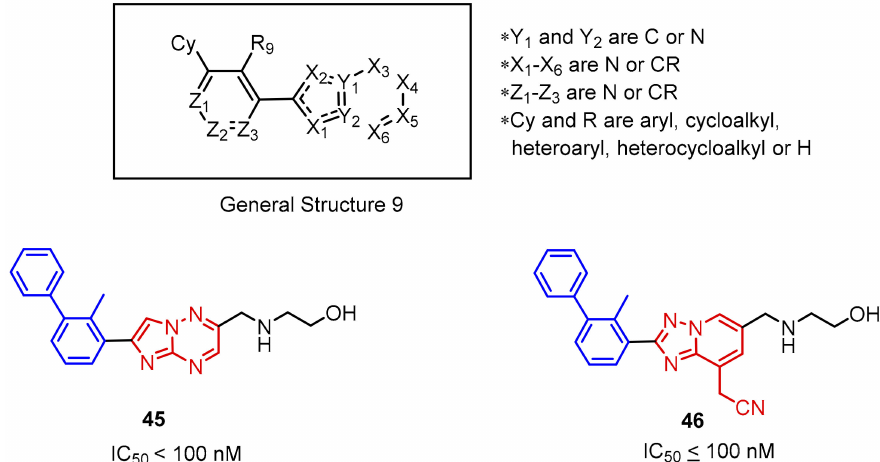
Figure 19. The general structure and examples of the PD-1 / PD-L1 inhibitors ( 45 and 46 ) reported by Incyte Corporation. The biphenyl fragment is shown in blue and the fused heteroaromatic system is shown in red. The next figure follows the same color pattern unless stated